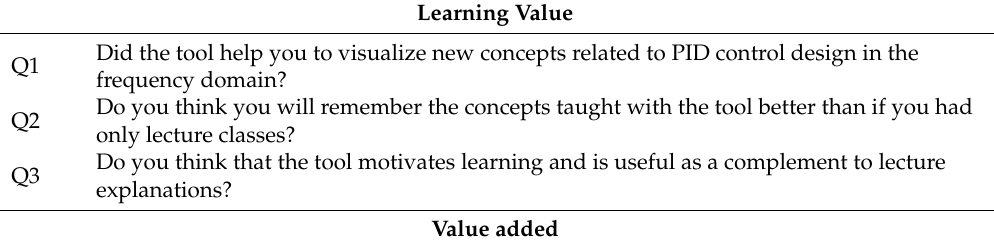
Table 7. Student questionnaire for tool assessment.